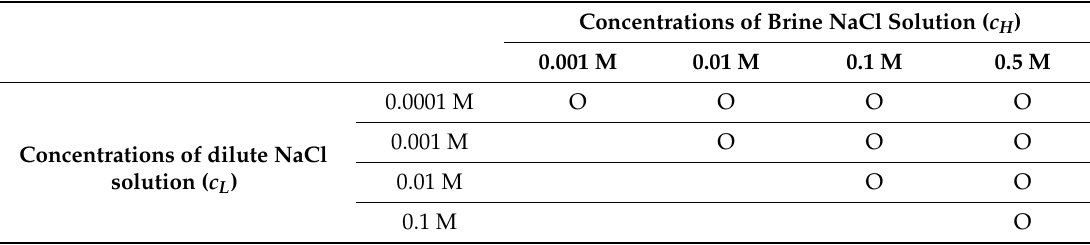
Figure 5. Two electrical circuits represent the experimental setup.